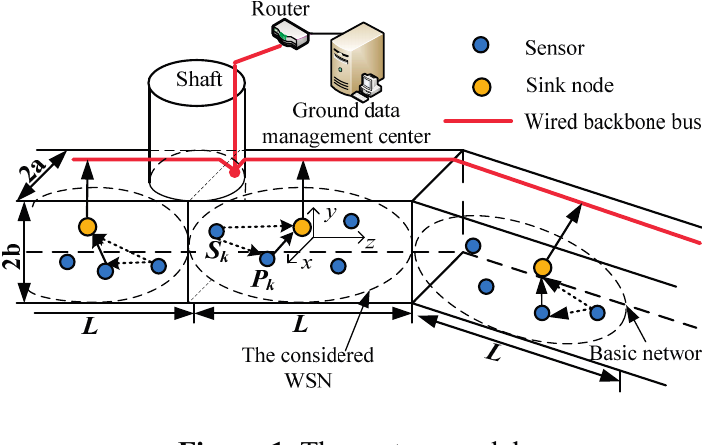
Figure 1. The system